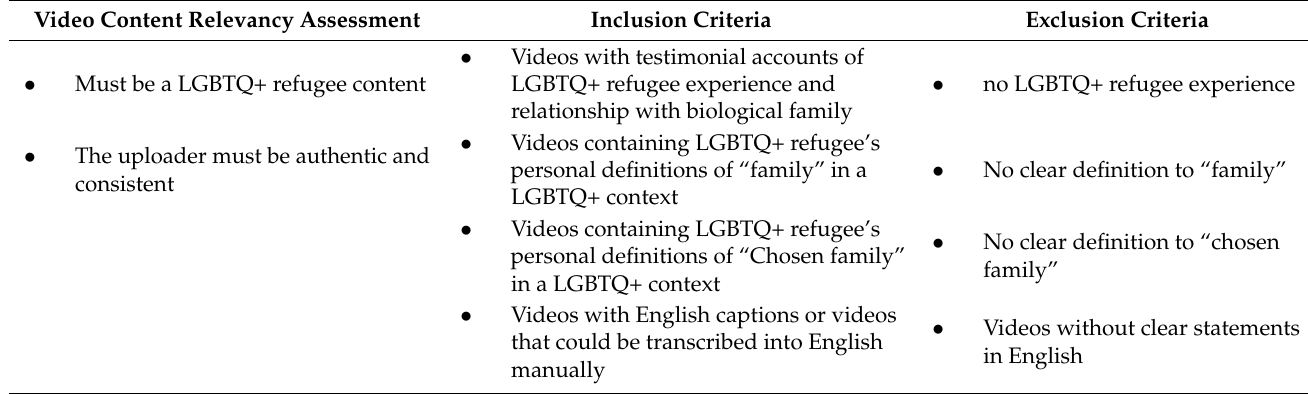
Table 1. Relevancy assessment and inclusion and exclusion